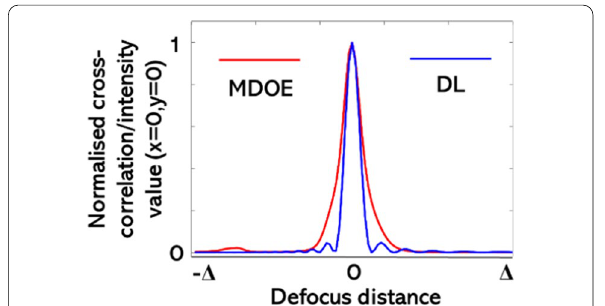
Fig. 4 Schematic of the LRRA. When α